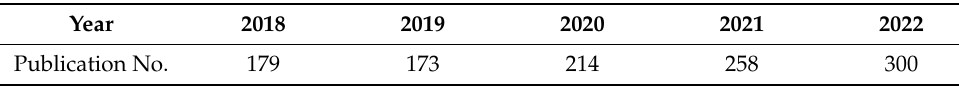
Table 3. Number of publications for skin